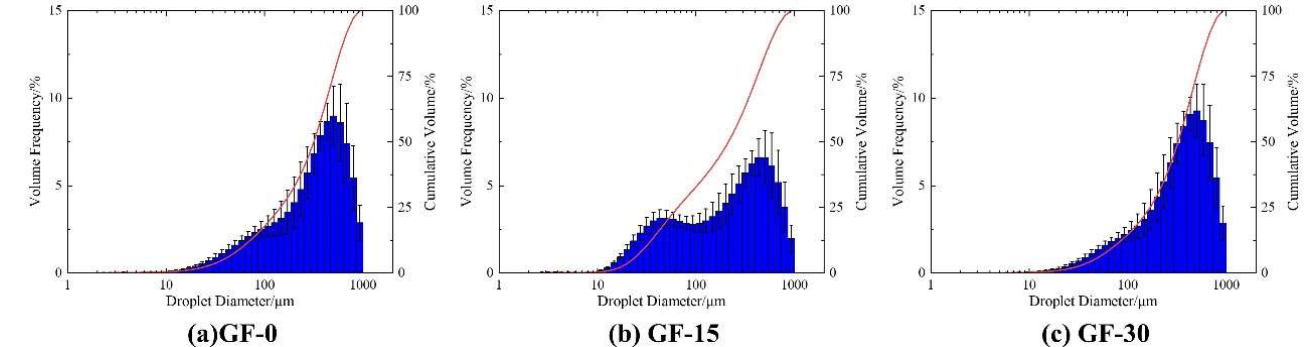
Figure 6. Droplet size distribution of different gelled fuels using DC